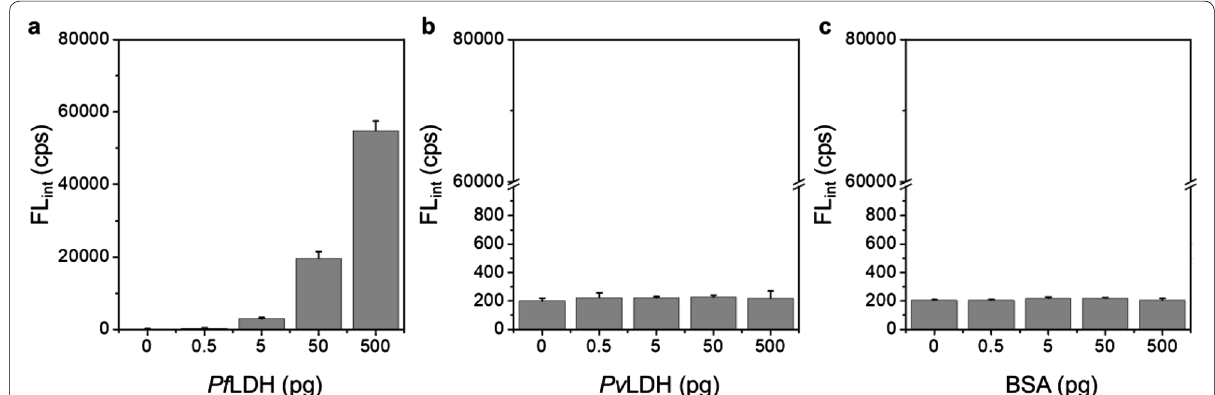
Fig. 5 Selectivity and specificity of microfluidic microplate-based immunoassay for detection of Pf LDH. Diagnosis of a Pf LDH, b Pv LDH, and c BSA in PBS-based blocking solution (n =